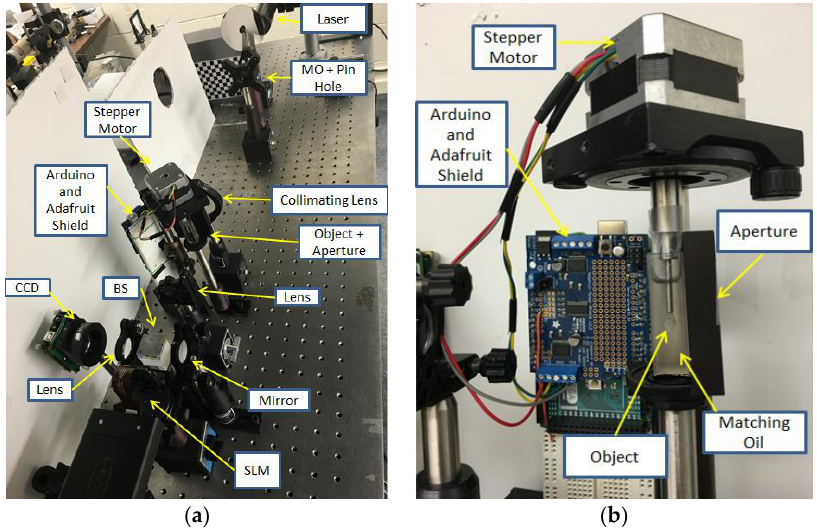
Figure 12. ( a ) Laboratory optical setup of the SLM based TIE system and ( b ) Arduino-controlled rotating stage assembly.